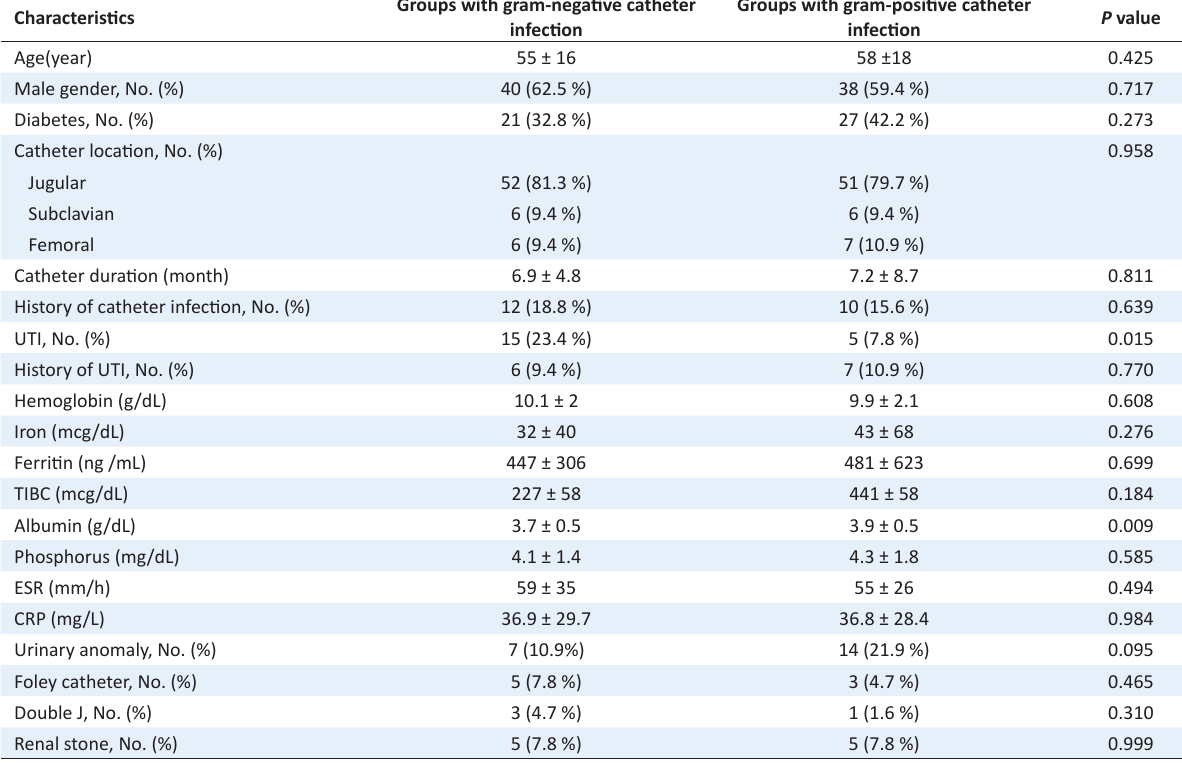
Table 2. The baseline characteristics and clinical data in groups with gram-negative bacteria catheter infection and gram-positive bacteria catheter infection